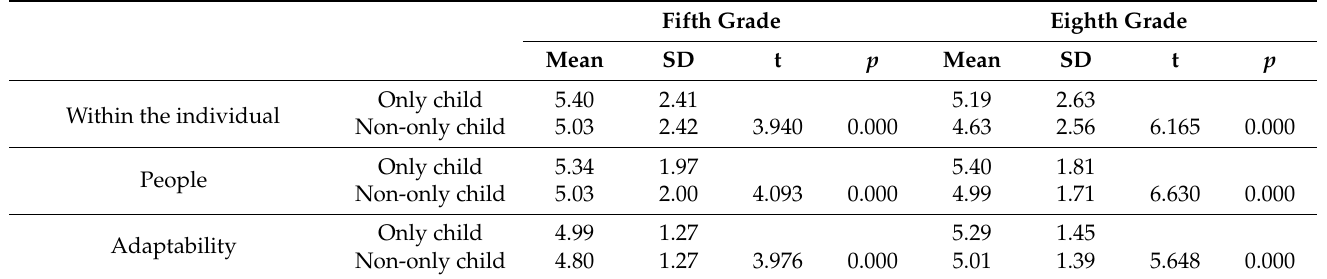
Table 13. Emotional management dimensions after